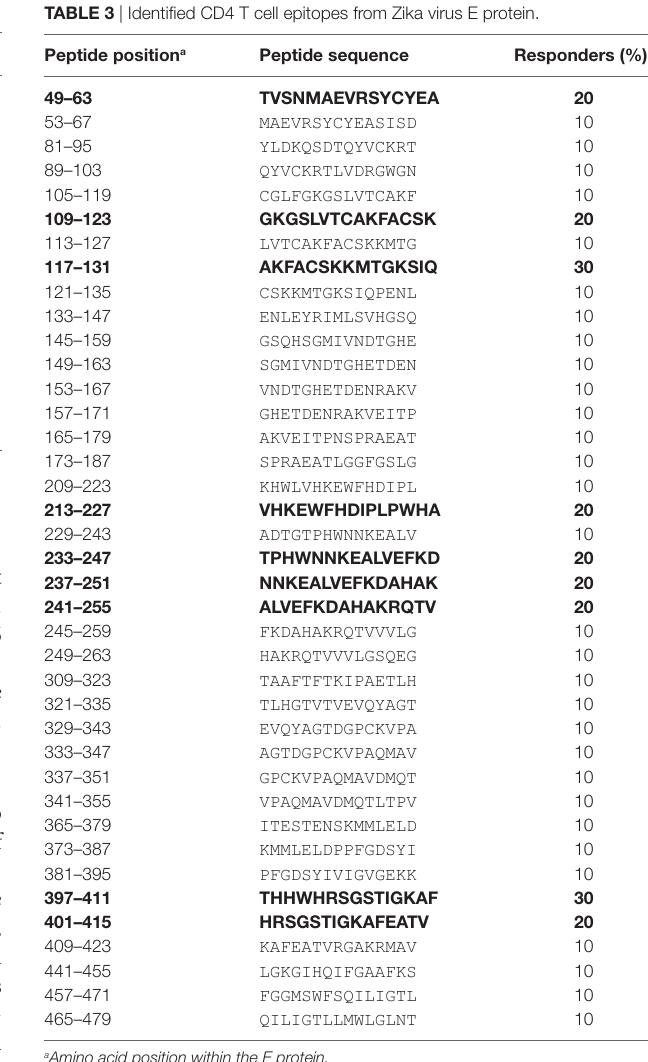
a Amino acid position within the E protein. b Percentage of responders recognizing a specific single peptide. Peptides recognized in ≥ 20% of responders are indicated in